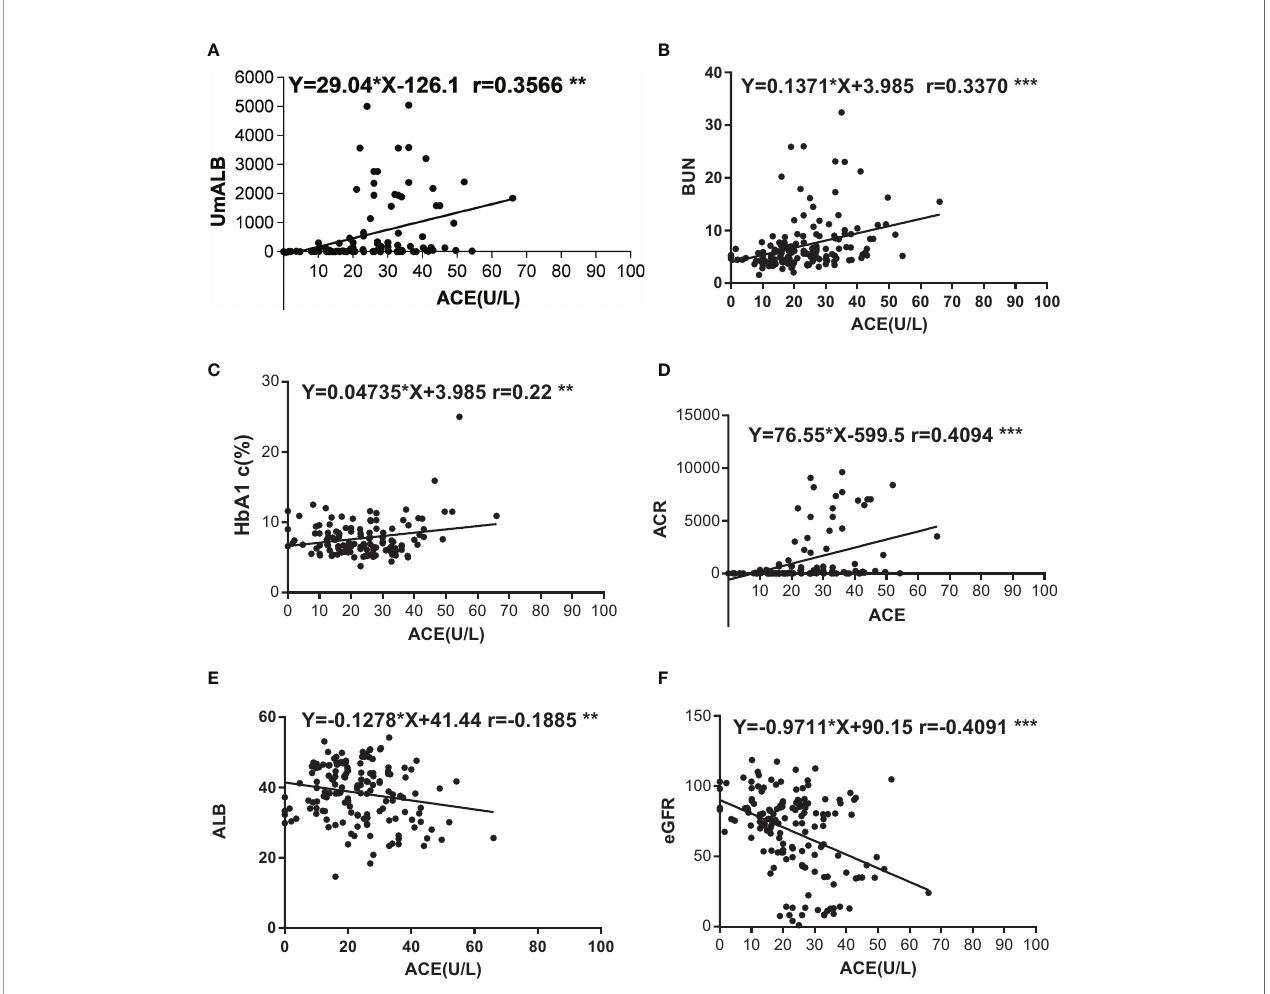
FIGURE 1 | Correlations of ACE with other indexes. (A) Correlation between UmALB level and ACE. Y = 29.04x - 126.141.0, R 2 = 0.121; (B) Correlation between BUN level and ACE. Y = 1371x + 3.985, R 2 = 0.109; (C) Correlation between HbA1c level and ACE. Y = 0.04735x + 6.621, R 2 = 0.050; (D) Correlation between ACR level and ACE. Y = 76.55x - 599.5, R 2 = 0.164; (E) Correlation between ALB level and ACE. Y = -0.1278x + 41.44, R 2 = 0.035; (F) Correlation between GFR level and ACE. Y = -9711x + 90.15, R 2 = 0.160. ** P < 0.01; *** P <